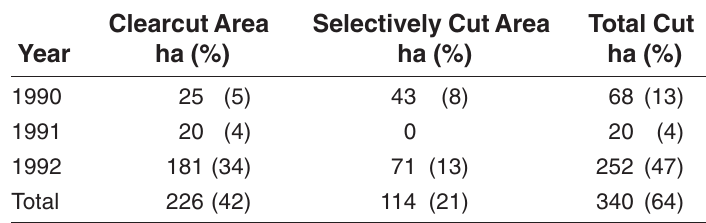
TABLE 2 Areal Extent of Salvage Logging Operations on the Baldwin Creek Watershed Clearcut Area Selectively Cut